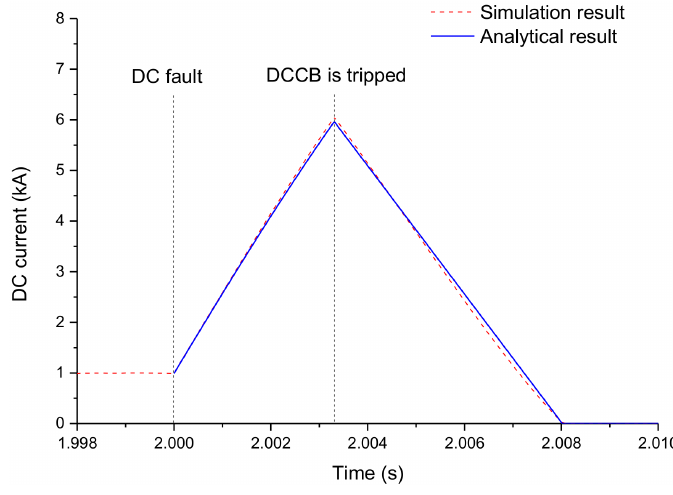
Figure 16. DC current of MMC with solution